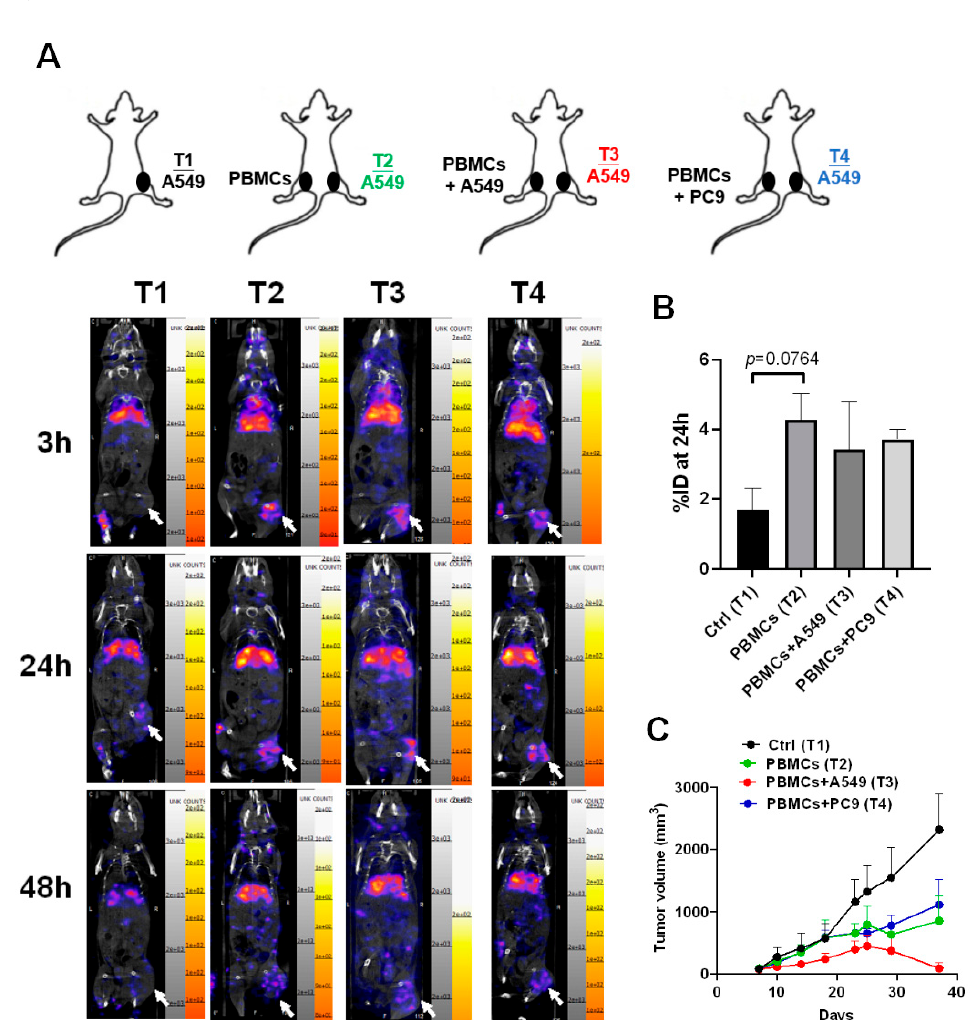
Figure 5. CD8 + T cells migrated to the tumor microenvironment and significantly suppressed tumor growth in the A549-derived tumor xenografts co-injected with healthy PBMCs and A549 cells. ( A ) A549 cells (2 × 10 6 ) were injected subcutaneously into the right legs of mice (Tumor 1 (T1) to T4), and after the tumor grew up 100 mm 3 , the PBMCs (1 × 10 7 ) alone or with A549 or PC9 (2 × 10 5 ) were injected into the left for 48 h circulation. 111 In-labeled nivolumab was injected into the mice and the radioactive signals were measured in 3, 24, and 48 h. Tumors are indicated by arrows. ( B ) Quantification for the radioactive signals of 24 h in the T1 to T4 tumors was measured based on an 8 µ Ci calibrated standard. ( C ) Meanwhile, the tumor volumes in T1 to T4 were recorded and compared. Tumors are indicated by arrows. n = 3 for each group.